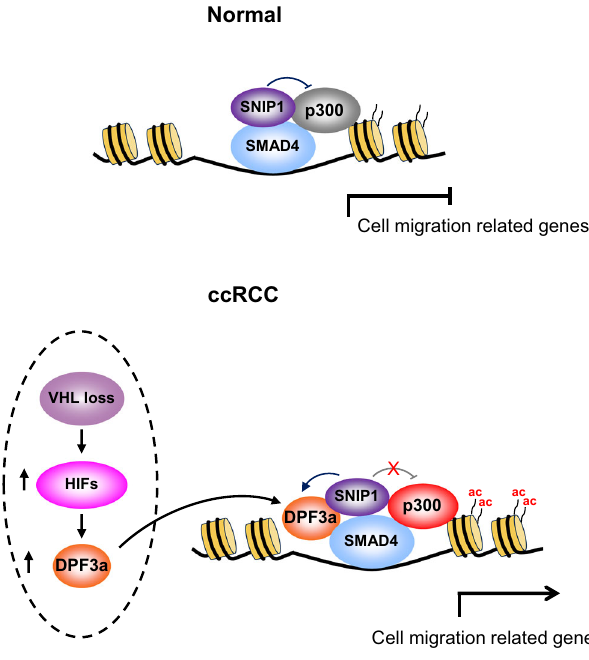
Fig. 7 | Modeland summary ofthe fi ndings. In normal conditions, SNIP1 bindsto SMAD4 and inhibits the associated p300 HAT activity, which leads to the tran- scriptional repression of cell migration-related genes. In ccRCC patients, loss of VHLactivateshypoxia-inducedfactors(HIFs)thatmayupregulatetheexpressionof DPF3a.The latterbinds toSNIP1 and releases its repressive effecton p300 activity, leadingtoenhancedlocalhistoneacetylation.Consequently,cellmigration-related genes are activated, which eventually promote ccRCC